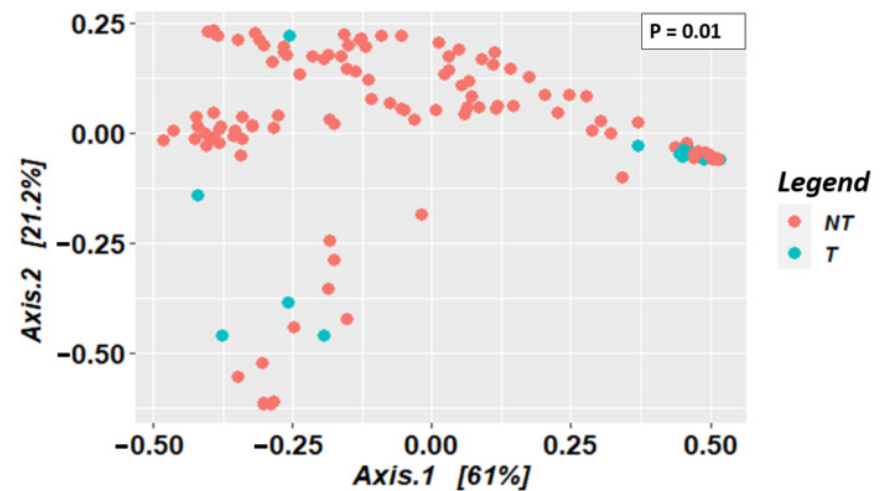
Figure 7. Distribution of tsetse fly samples according to their microbiota composition, based on principal coordinates analysis using the Bray–Curtis index, in non-teneral and teneral flies (NT: non-teneral; T: teneral).